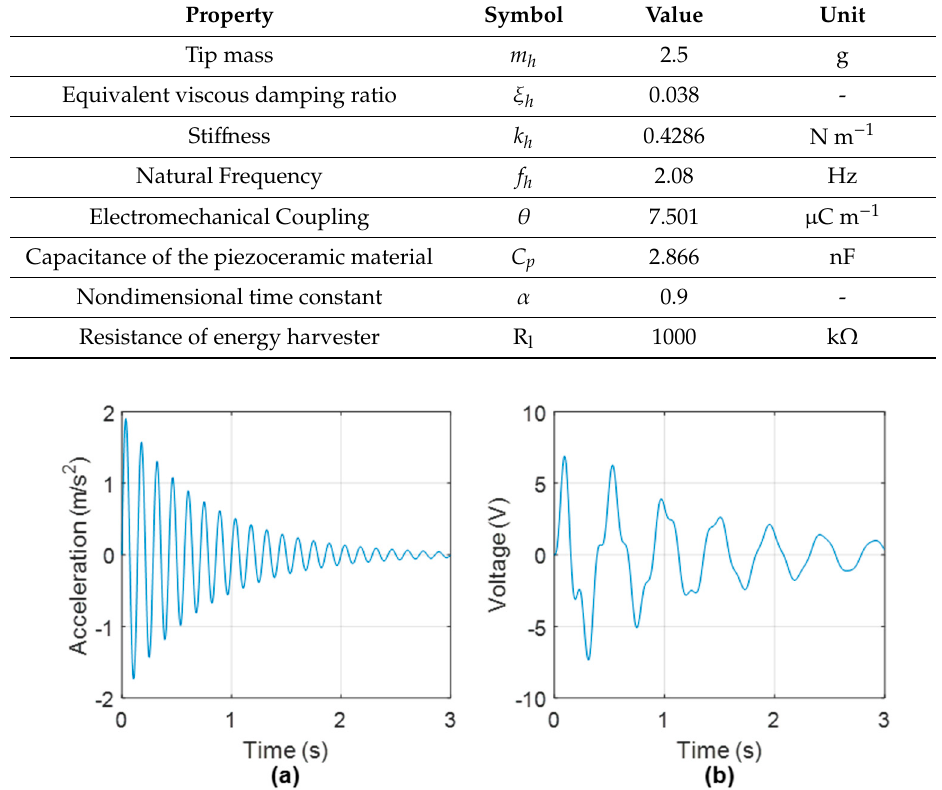
Table 1. Harvester parameters used in the simulation [21,26].